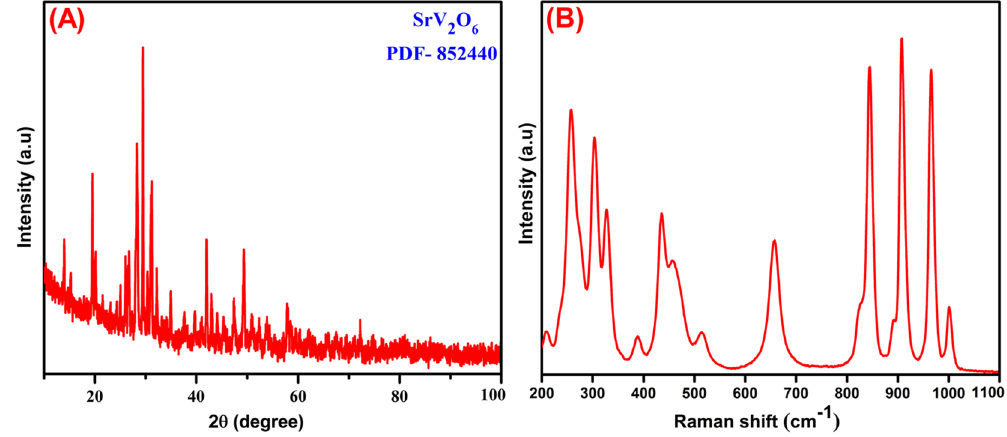
Figure 1. XRD pattern of SrV 2 O 6 ( A ) and Raman spectrum of SrV 2 O 6 ( B